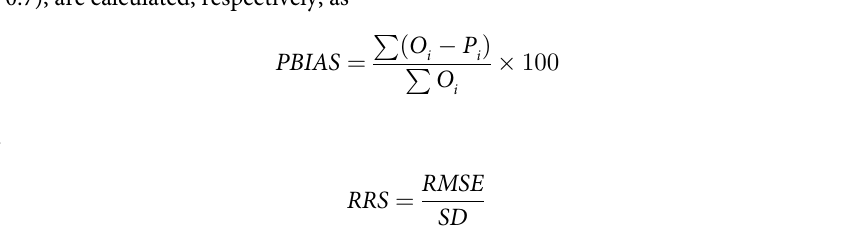
RMSE RRS ¼ SD ffiffiffiffiffiffiffiffiffiffiffiffiffiffiffiffiffiffiffiffiffiffiffiffiffiffi s P ð O (cid:0) P Þ 2 i i RMSE ¼ n ¼ (cid:0) Ln ð 0 : 5 Þ � k ð 5 Þ T 50